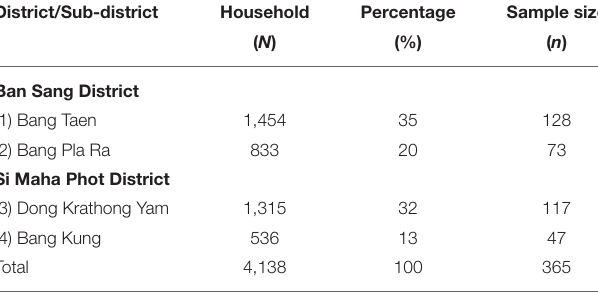
FIGURE 1 | Conceptual framework showing inter-linkages between different elements affecting the resiliency of agricultural systems. TABLE 1 | Sample size estimated for the present survey.